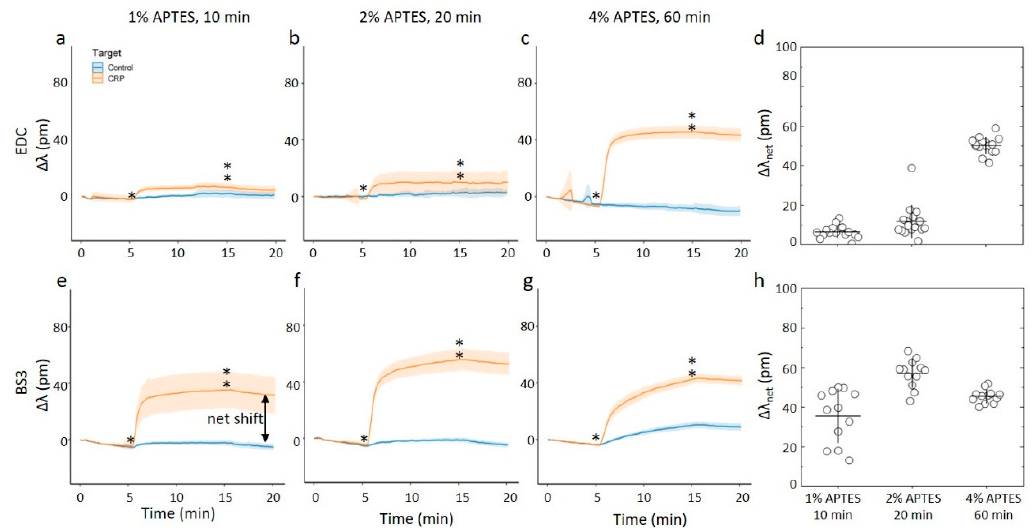
Figure 7. ( a – c , e – f ) Online measurements of CRP capture on ring resonator sensor chips silanized with APTES using 96% ethanol as the silanization solvent. The assay steps consisted of a PBS-BSA rinse for 5 min before a 2.5 ug / mL CRP in BSA-PBS for 10 min and a final PBS-BSA rinse for 5 min. Single- and double-stars mark the start and end of CRP in BSA-PBS step, respectively. For these experiments, at least 12 rings were used for technical replicates. ( a – c ) CRP capture onto chips where the anti-CRP capture molecule has been immobilized by carbodiimide chemistry onto chips silanized using APTES concentrations and durations of ( a ) 1% APTES, 10 min, ( b ) 2% APTES, 20 min, and ( c ) 4% APTES, 60 min. ( d ) The average net shift in resonance wavelength due to CRP capture onto the ring resonator chips with anti-CRP immobilized by carbodiimide chemistry. ( e – g ) CRP capture onto chips where the anti-CRP capture molecule has been immobilized by using the BS3 linker onto chips silanized using APTES concentrations and durations of ( e ) 1% APTES, 10 min, ( f ) 2% APTES, 20 min, and ( g ) 4% APTES, 60 min. ( h ) The average net shift in resonating wavelength due to CRP capture onto the ring resonator chips with anti-CRP immobilized with the BS3 linker.